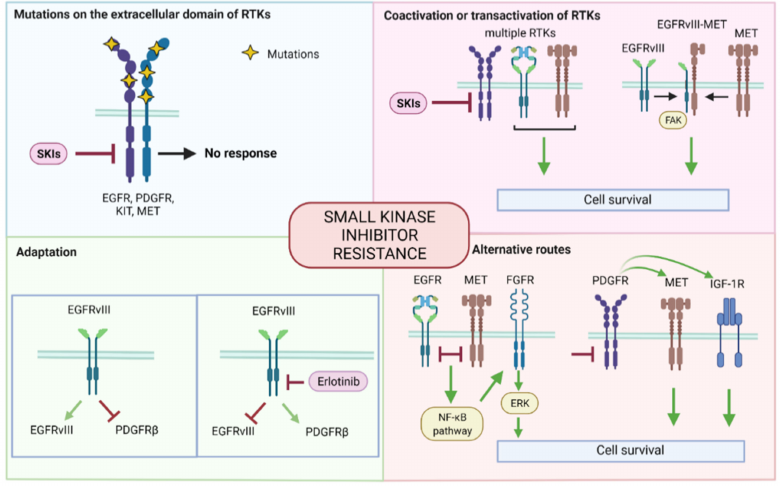
Figure 2. Summary of small kinase inhibitor resistance mechanisms. The mechanisms can be grouped as follows: mutations on the extracellular domain of RTKs, coactivation and transactivation of RTKs, adaption, and alternative routes. SKI: small kinase inhibitor, EGFR: epidermal growth factor receptor, PDGFR: platelet-derived growth factor receptor, c-KIT: stem cell factor receptor, c-MET: mesenchymal epithelial transition factor, RTK: tyrosine kinase receptor, PTEN: phosphatase and tensin homolog, FGFR: fibroblast growth factor receptor, IGF-1R: insulin-like growth factor 1 receptor, NF- κ B: nuclear factor kappa-light-chain-enhancer of activated B cells, ERK: extracellular signal-regulated